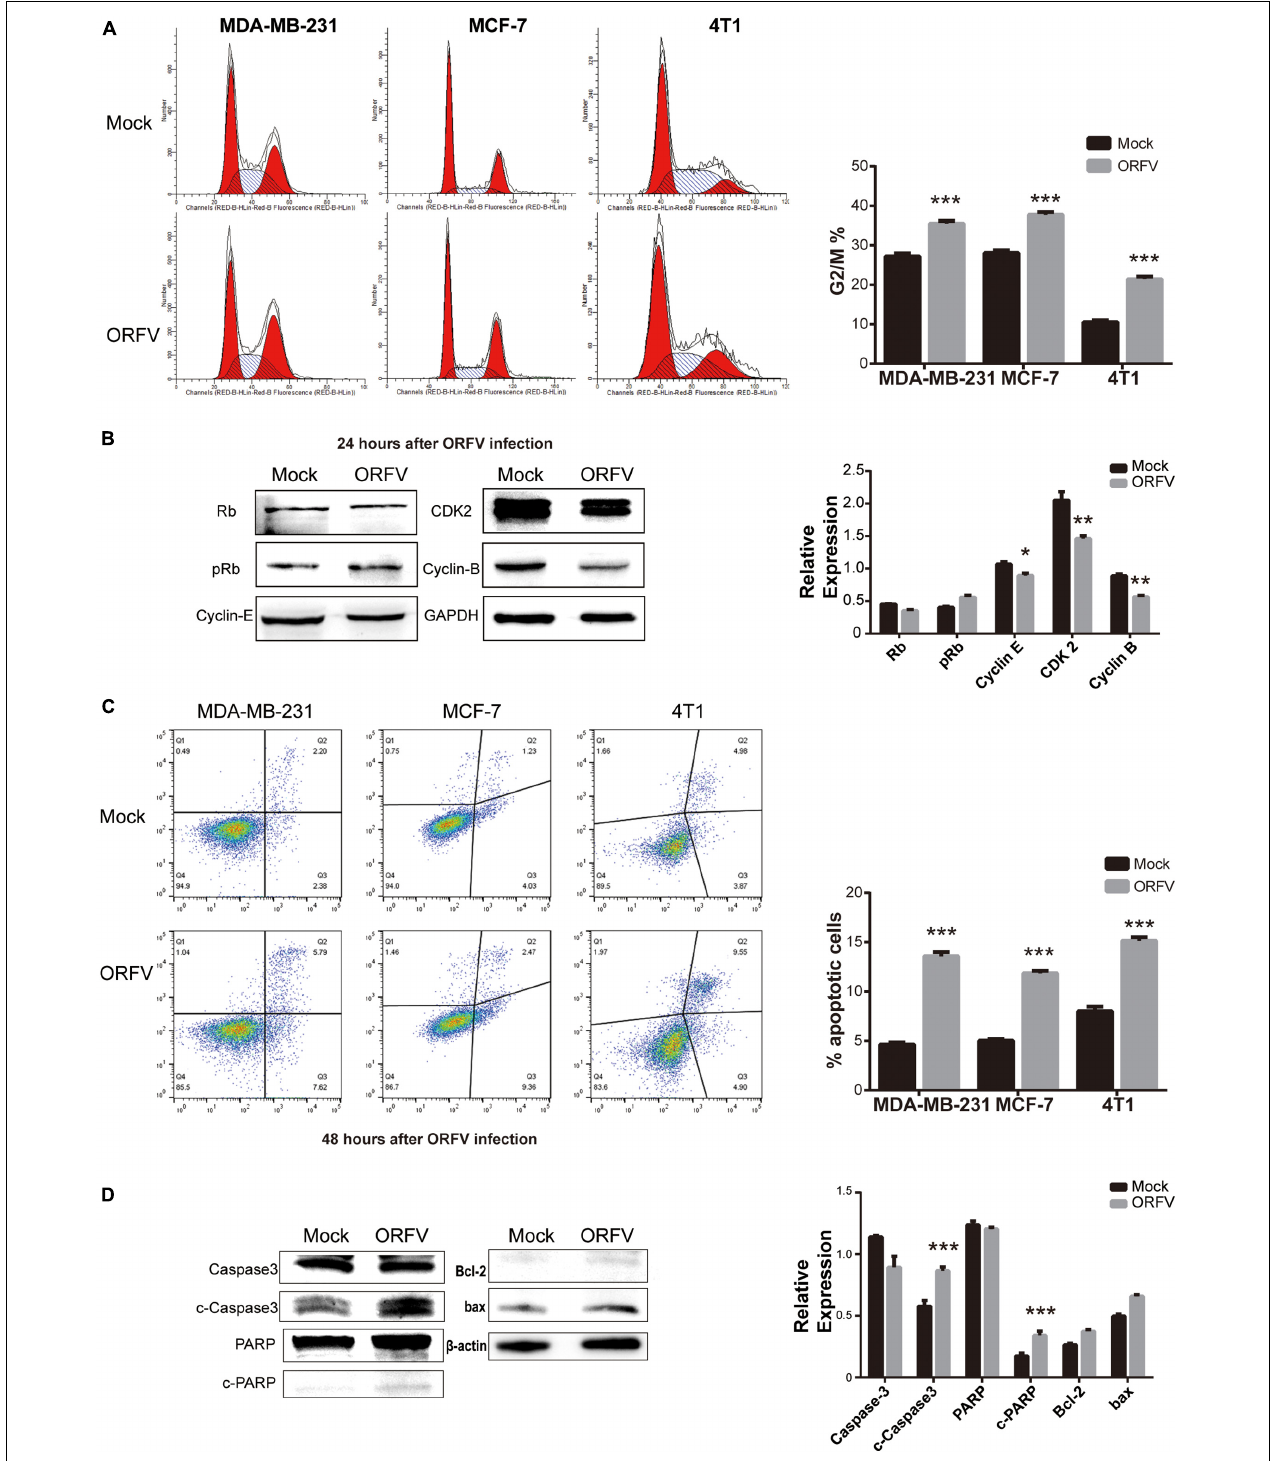
FIGURE 2 | ORFV regulates breast cancer cell cycle and apoptosis. (A) MDA-MB-231, MCF-7 and 4T1 were infected with ORFV (MOI = 5) or PBS for 24 h. Flow cytometry detected cell cycle by Cell Cycle Staining Kit. (B) MDA-MB-231 cells were infected with ORFV (MOI = 5) or PBS for 24 h. Western blotting analyses of the relative expression of Rb, phospho-Rb (p-Rb), Cyclin-E, CDK2, Cyclin-B. (C) MDA-MB-231, MCF-7 and 4T1 were infected with ORFV (MOI = 5) or PBS for 48 h. Flow cytometry detected apoptosis by Annexin V-FITC/PI Apoptosis Detection Kit. (D) MDA-MB-231 cells were infected with ORFV (MOI = 5) or PBS for 48 h. Western blotting analyses of the relative expression of cleaved Caspase-3 (c-Caspase-3), cleaved PARP (c-PARP), Bcl-2 and bax. The results are expressed as the means ± SEM of three independent experiments. * p < 0.05; ** p < 0.01; *** p < 0.001.